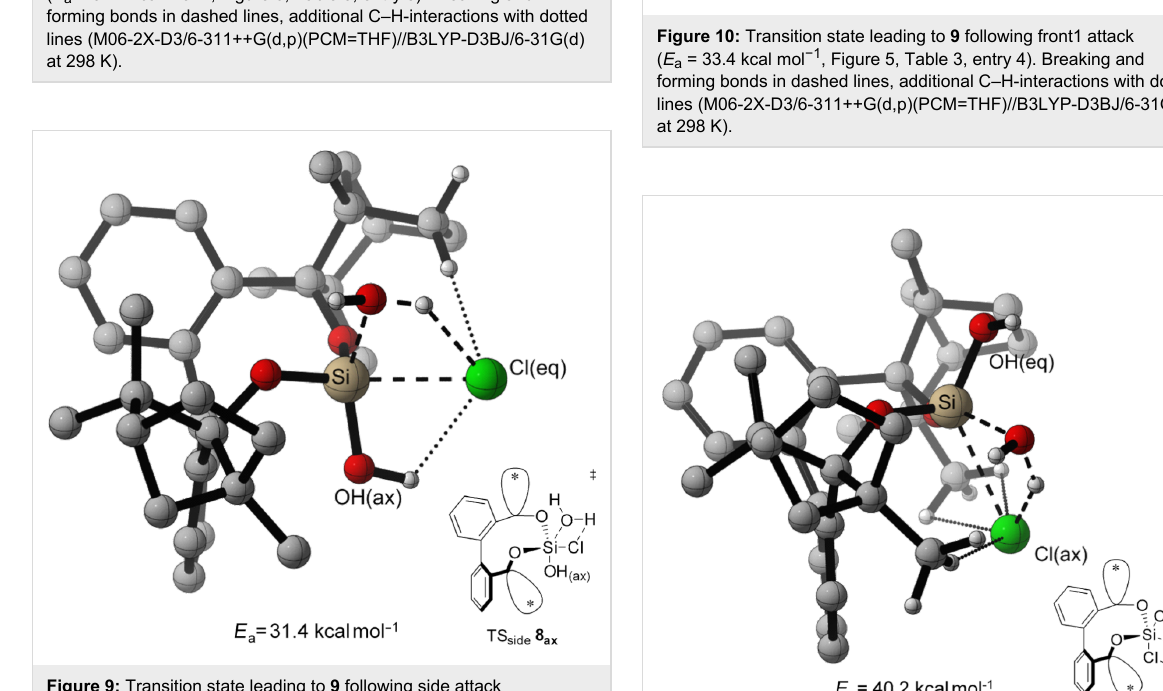
Figure 9: Transition state leading to 9 following side attack ( E a = 31.4 kcal mol − 1 , Figure 5, Table 3, entry 6). Breaking and forming bonds in dashed lines, additional C–H-interactions with dotted lines (M06-2X-D3/6-311++G(d,p)(PCM=THF)//B3LYP-D3BJ/6-31G(d) at 298 K).